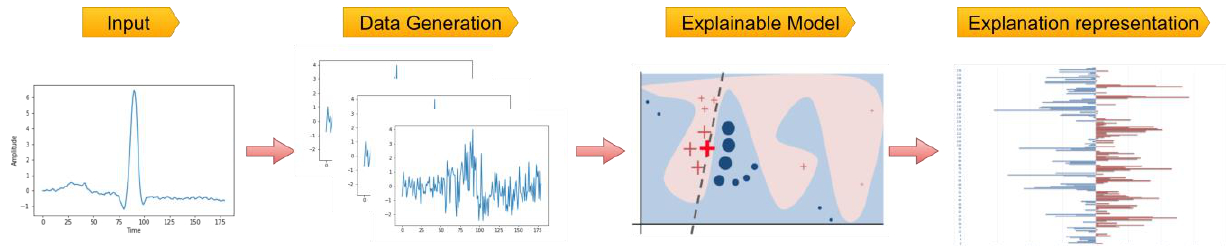
Figure 1. LIME procedure to generate